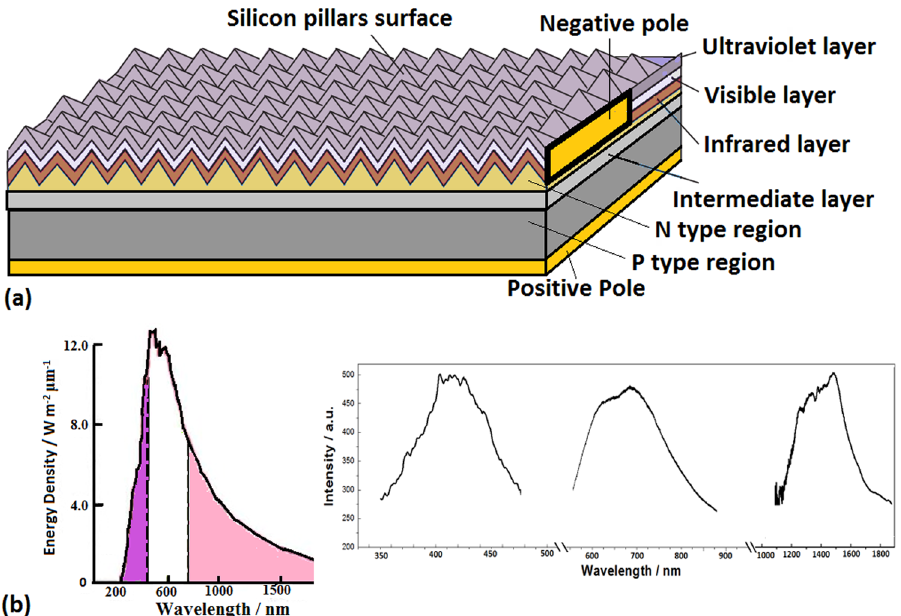
Figure 2. ( a ) The three layers structure of photovoltaic system involving ultraviolet layer, visible layer and infrared layer built under the silicon pillars surface; ( b ) The solar spectrum and the spectra related to the electronic states in the inset showing the ultraviolet spectrum in the ultraviolet layer, the visible spectrum in the visible layer and the infrared spectrum in the infrared layer.